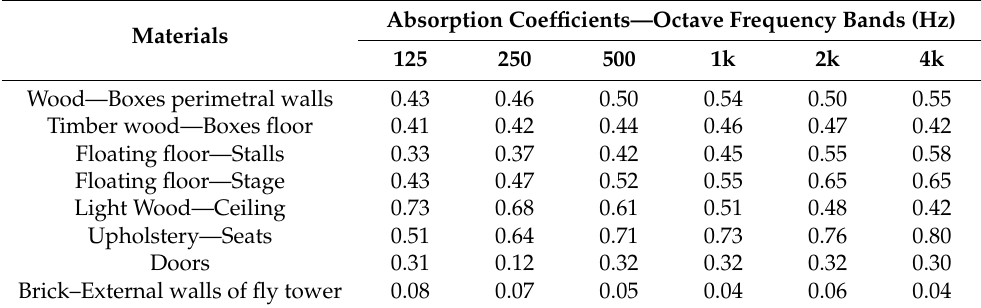
Table 4. Absorption coefficients of the materials considered in the model of Ponchielli theater of Cremona.